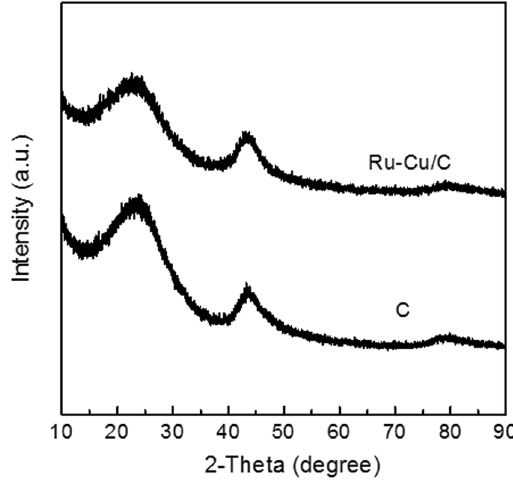
Figure 3. The XRD patterns of the C and Ru-Cu/C.